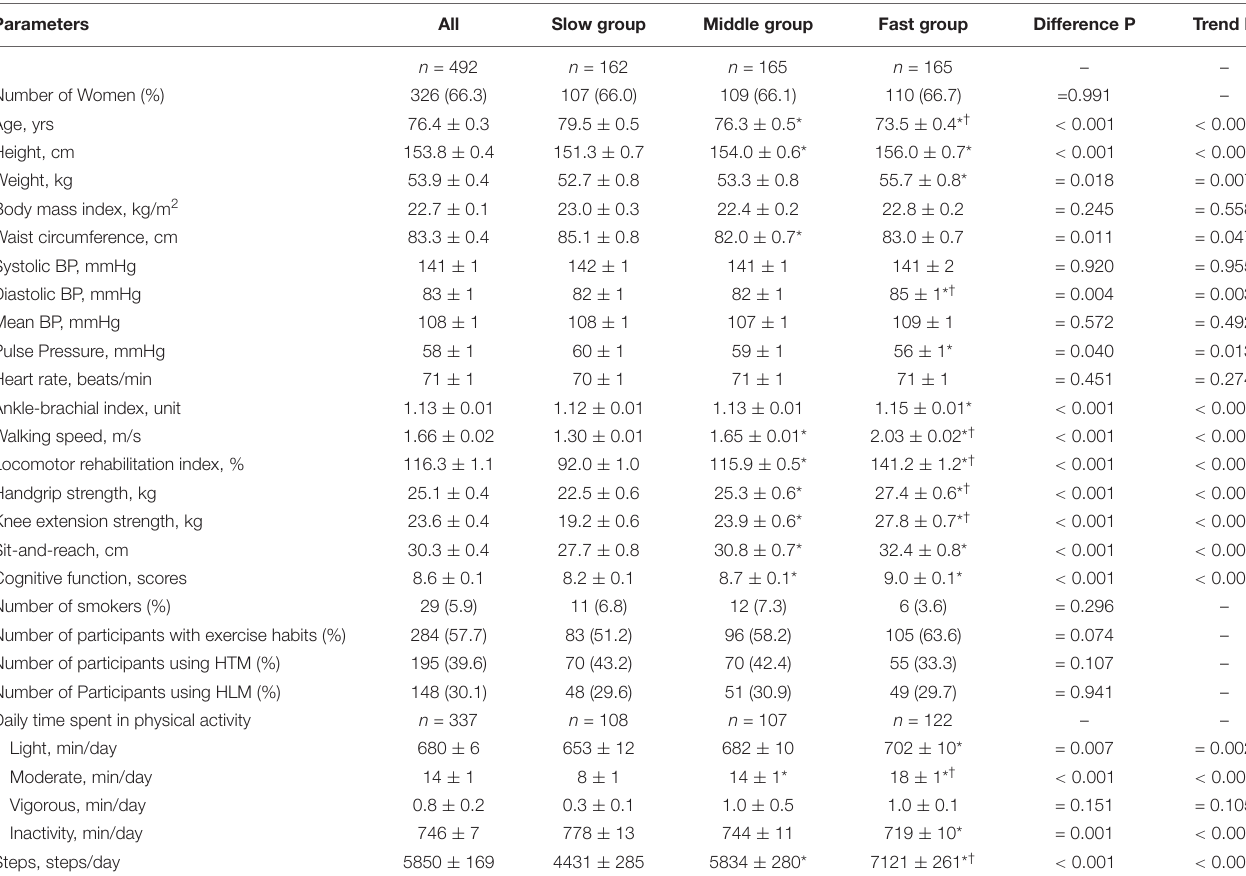
TABLE 1 | Characteristics of the participants.